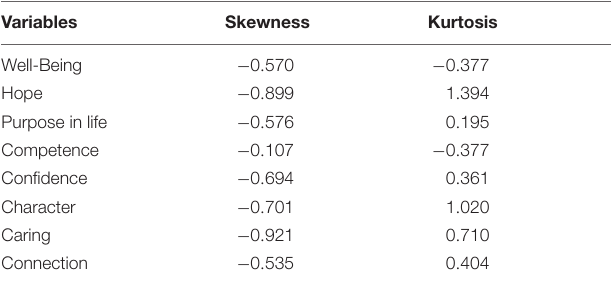
TABLE 2 | Skewness and kurtosis values of the study constructs. Variables Skewness Kurtosis